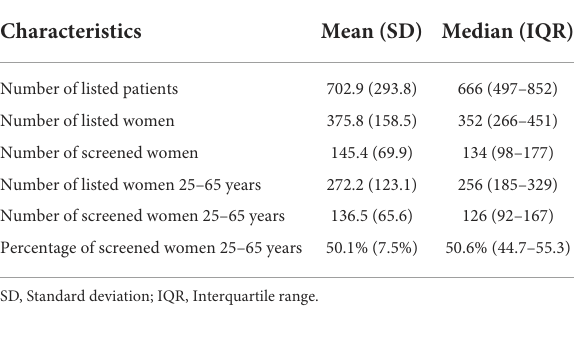
TABLE 1 Characteristics of the listed patients per GP.